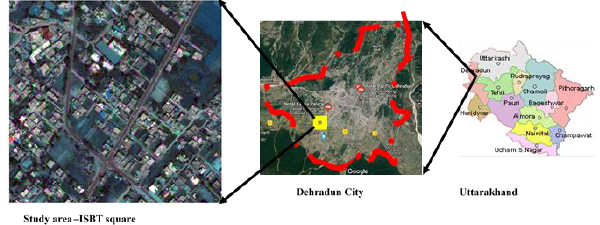
Figure 1 Study area, Dehradun